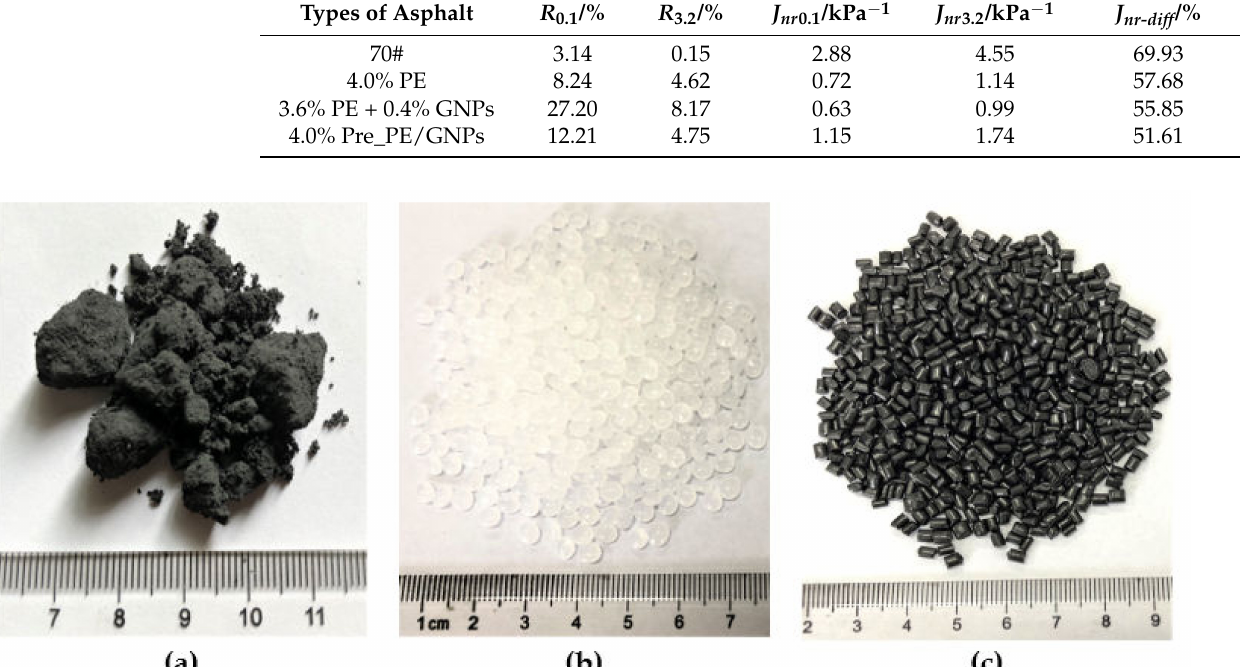
Figure 2. The images of raw materials used in the study. ( a ) GNPs powders, ( b ) PE particles, ( c ) Pre_GNPs/PE